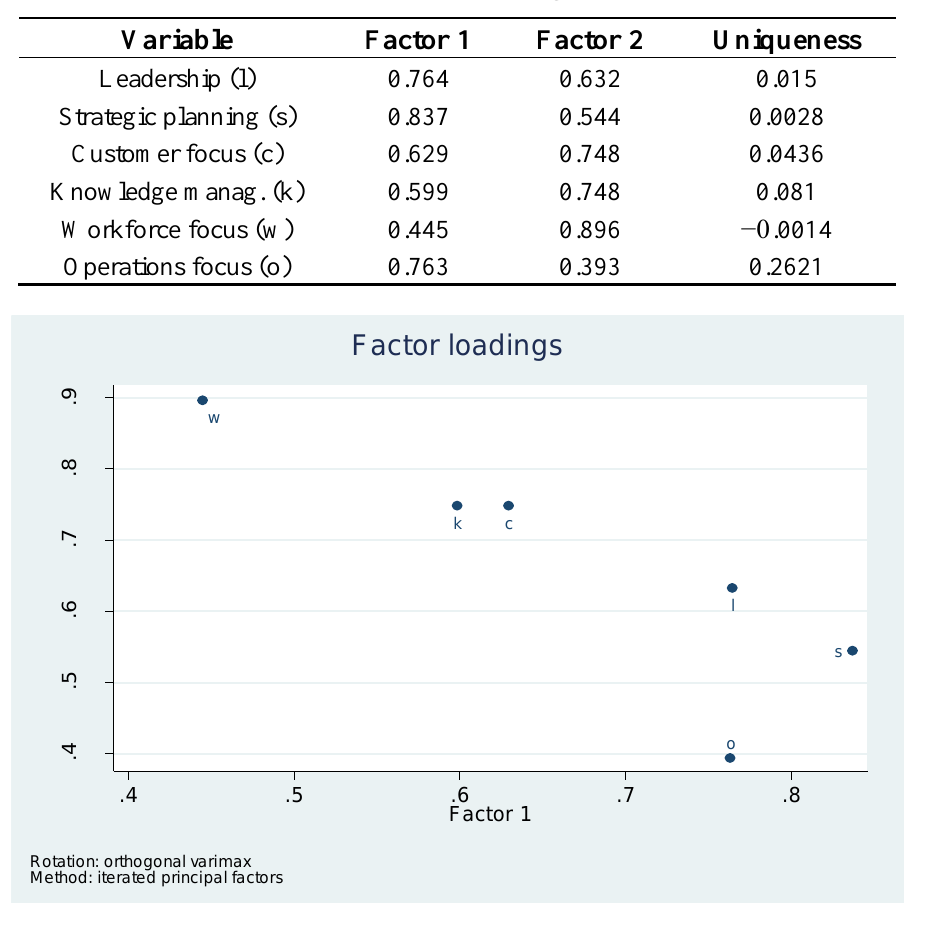
Figure 5. Factor loadings associated with factor 1 and factor 2. Table 8. Technical efficiency (varimax